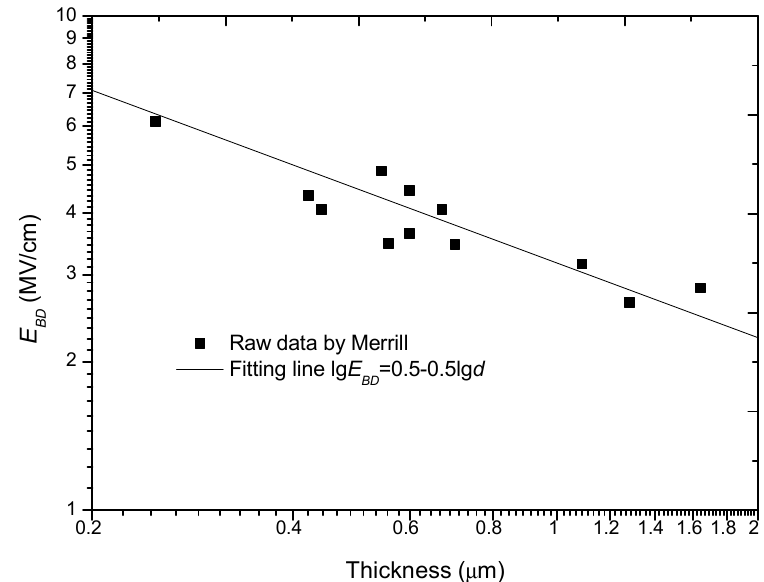
Figure 4. Experimental results to support the double-logarithm relation of E BD with d . Table 2. Four typical relations for the thickness e ff ect of solid